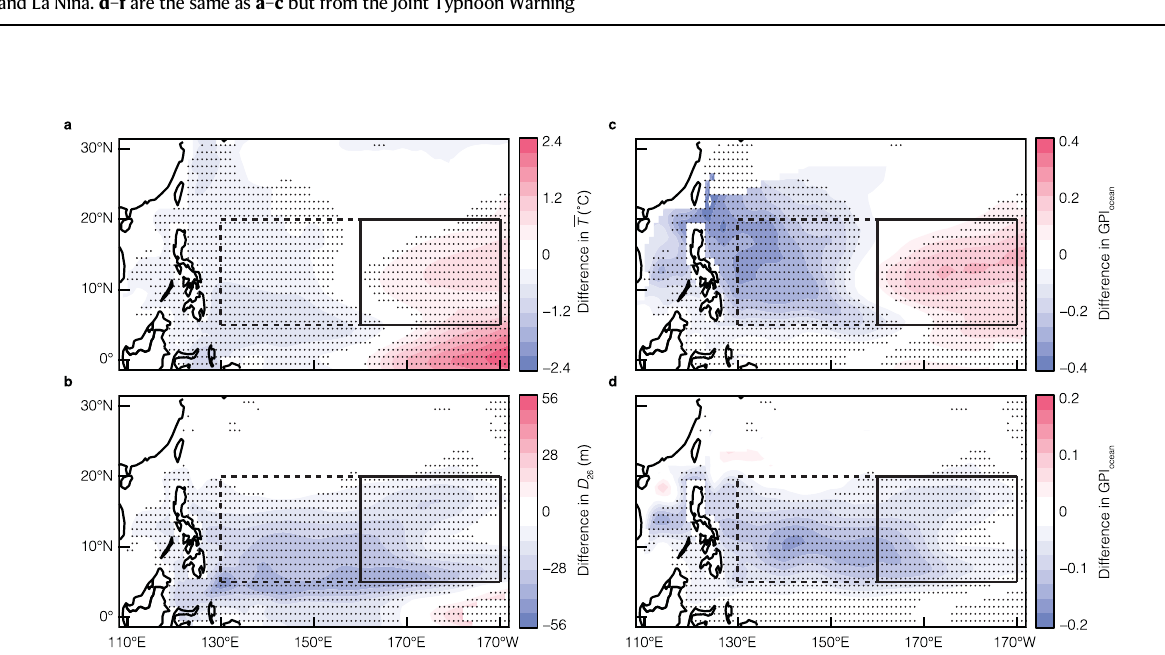
listed in Supplementary Table S1.